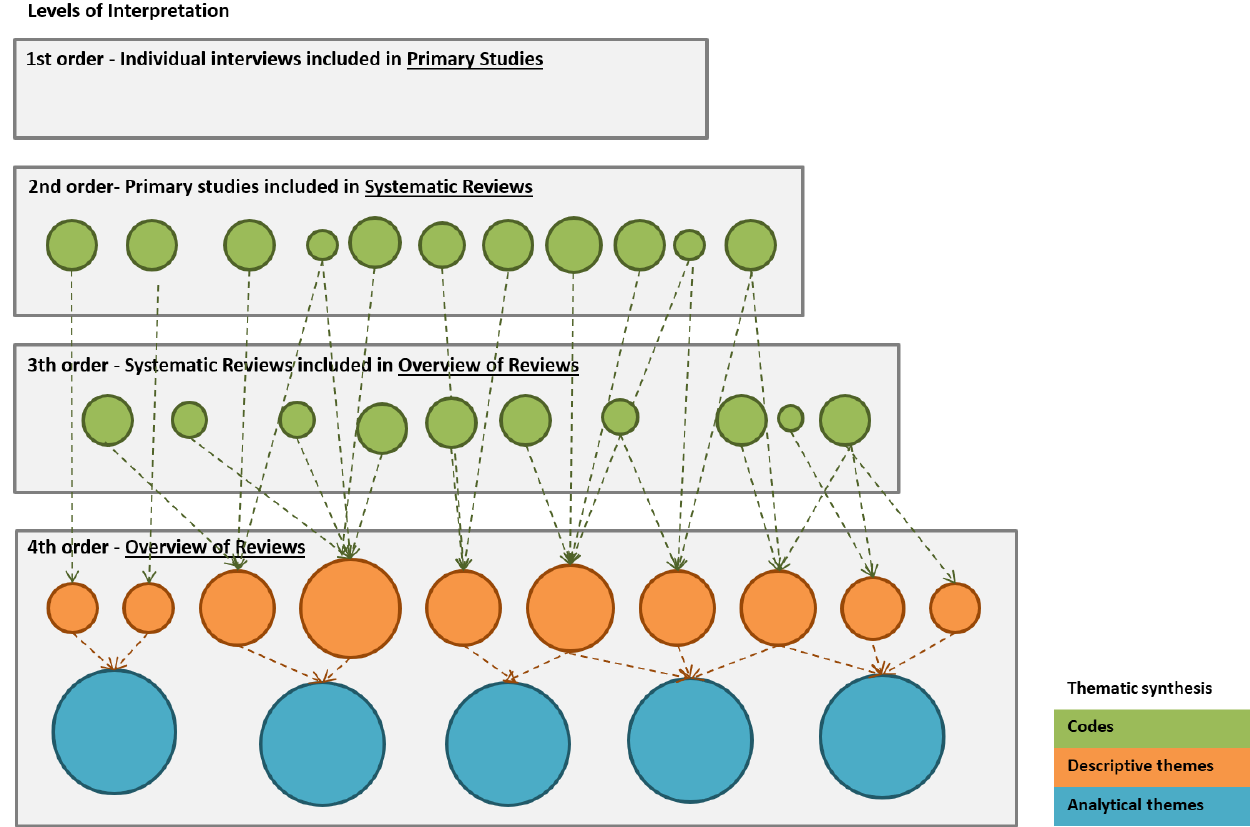
Figure 1. Thematic synthesis stages and levels of interpretation. Levels of interpretation: adapted from Pierce et al. 24 , thematic synthesis stages based on Thomas and Newman 46